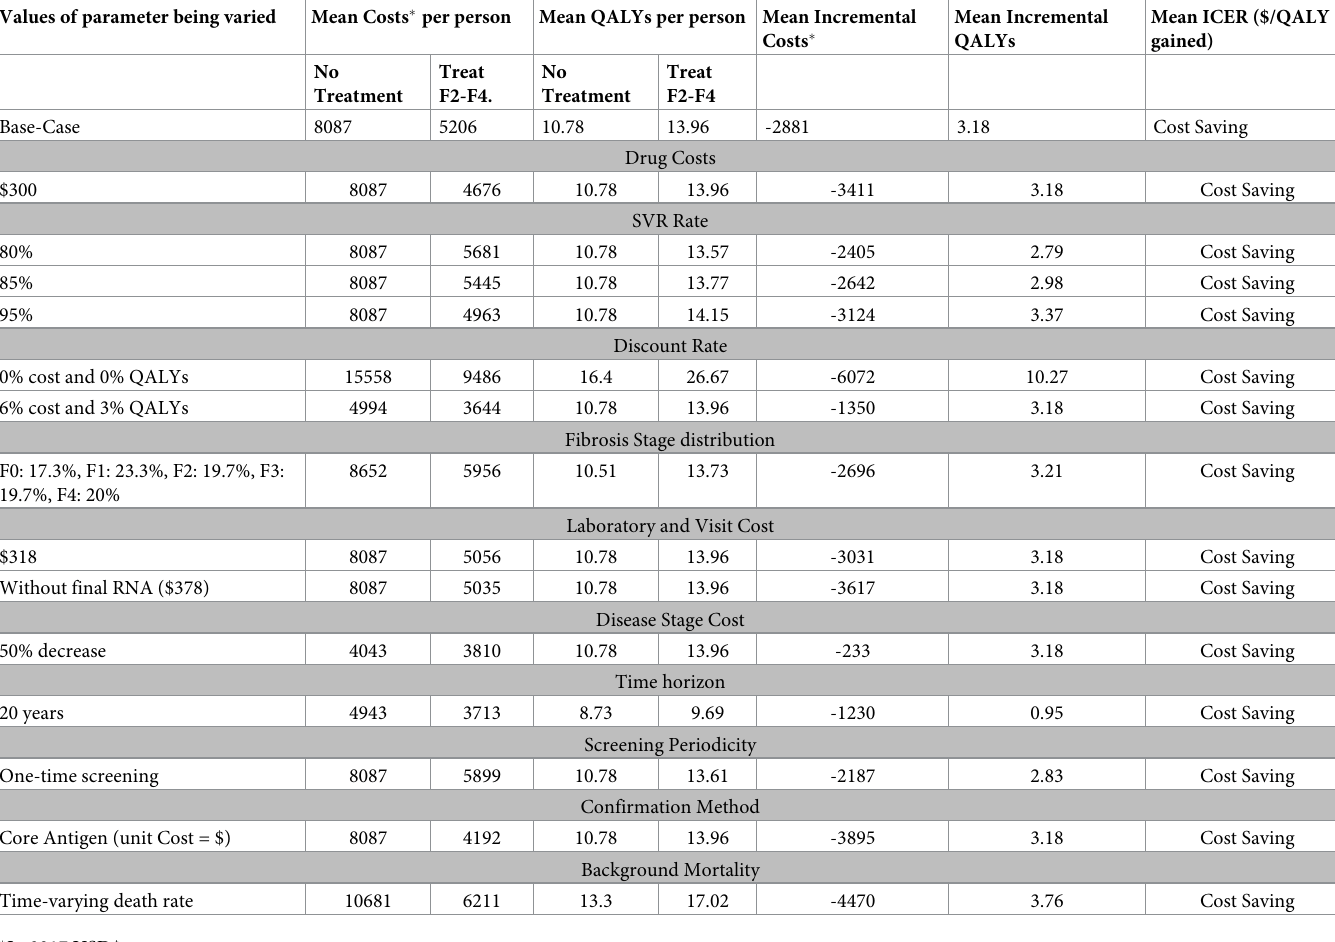
Table 1. Sensitivity analyses of cost-effectiveness results for HCV treatment for individuals with moderate-severe liver disease (F2-F4) versus no treatment. ICER: Incremental cost-effectiveness ratio. QALY: quality adjusted life year. SVR: Sustained viral response. Values of parameter being varied Mean Costs � per person Mean QALYs per person Mean Incremental